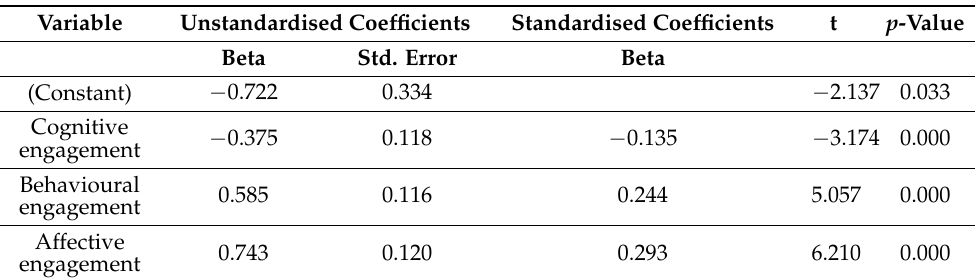
Table 9. Multiple regression analysis results.